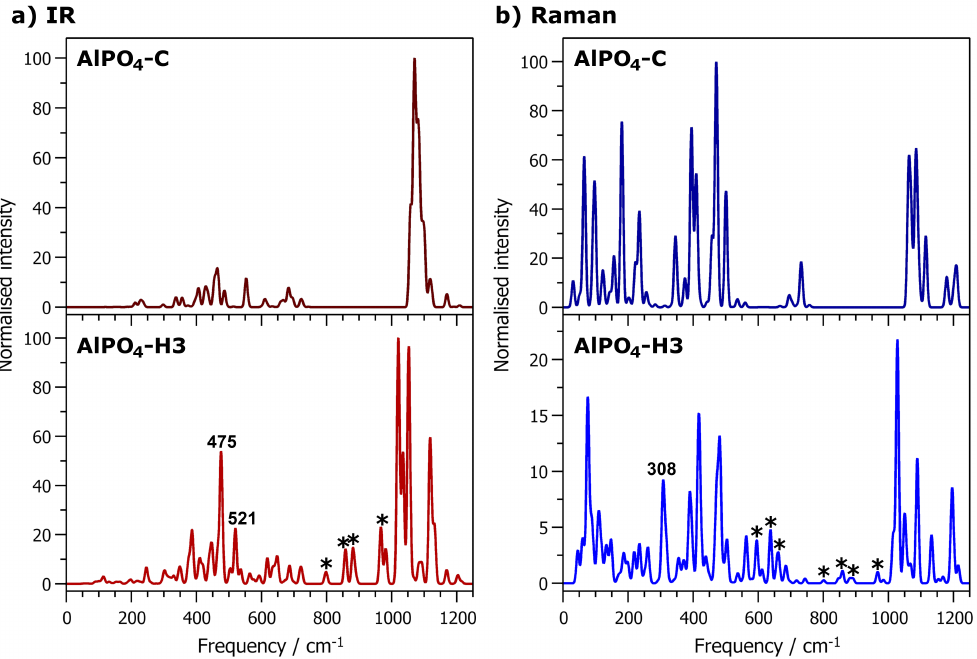
Figure 6. Computed IR ( left ) and Raman ( right ) spectra of AlPO 4 -C ( top) and AlPO 4 -H3 ( bottom ). Frequency labels are included for modes that are discussed prominently in the text, whereas asterisks indicate modes that are mentioned